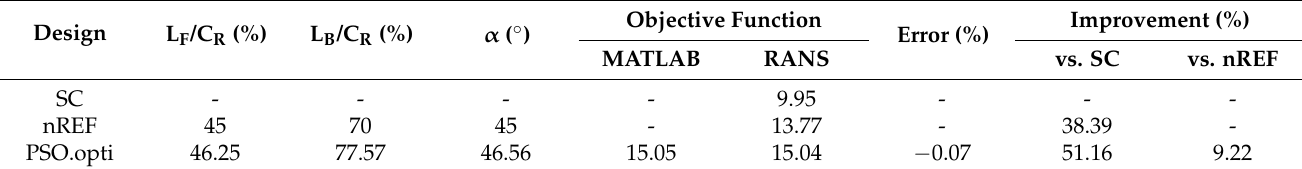
Table 5. Optimization results.